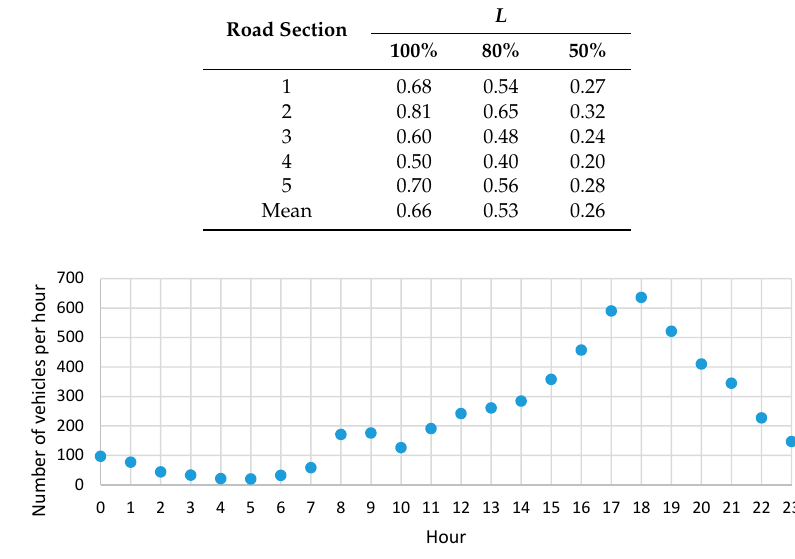
Figure 7. Number of vehicles per hour along Vreta Gårds väg, a residential road in Botkyrka. Total vehicle flow 4–10 November 2014 was 5524.